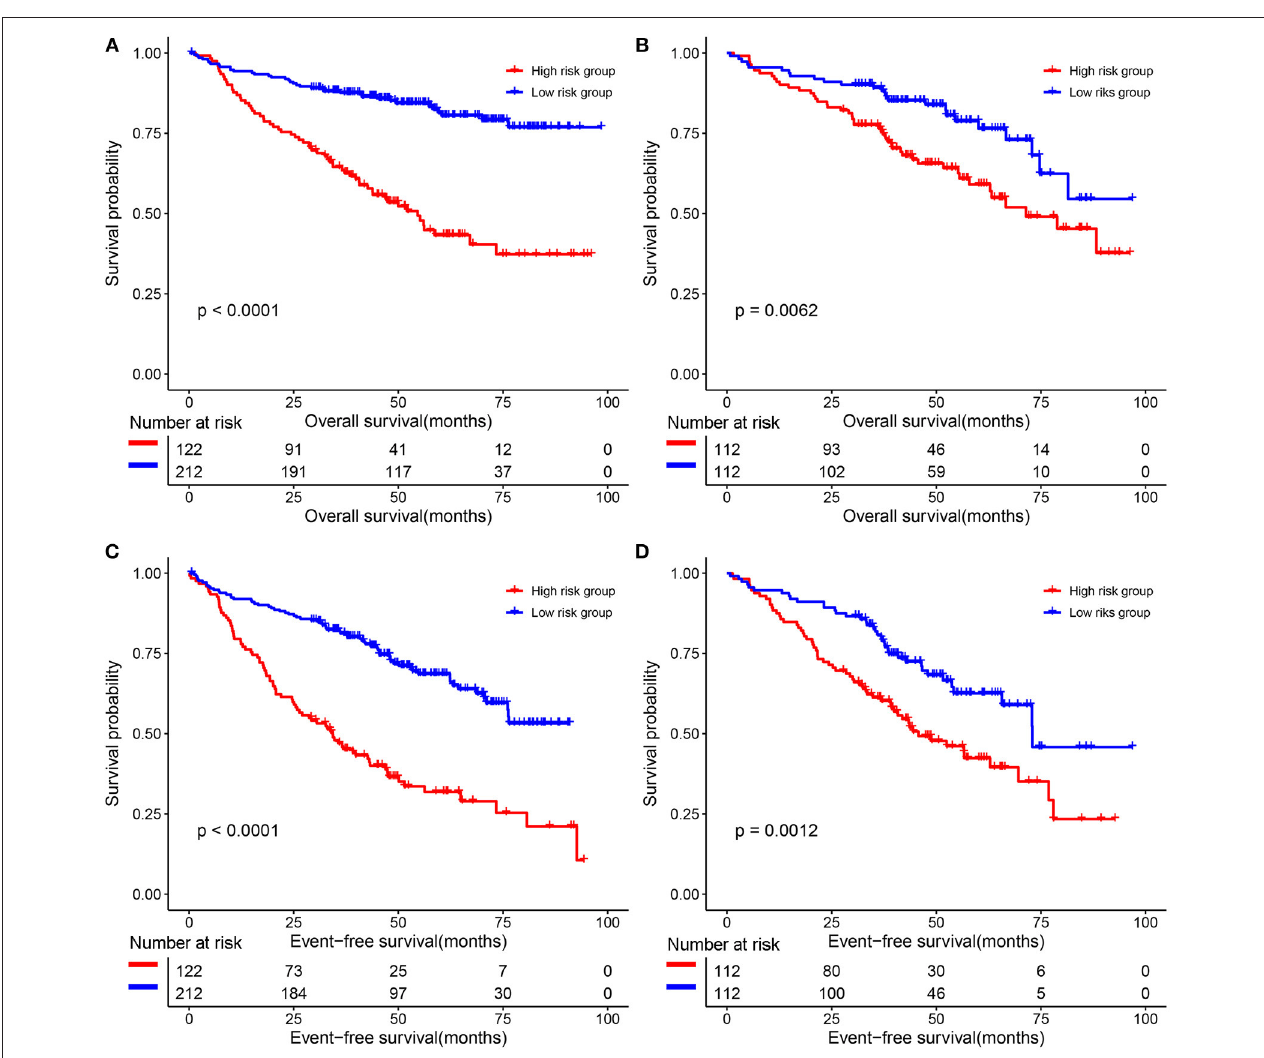
FIGURE 3 | The correlations between the 9-gene signature and the overall survival (OS) and event-free survival (EFS) of patients with MM. (A) OS in the training set. (B) OS in the test set. (C) EFS in the training set. (D) EFS in the test set.